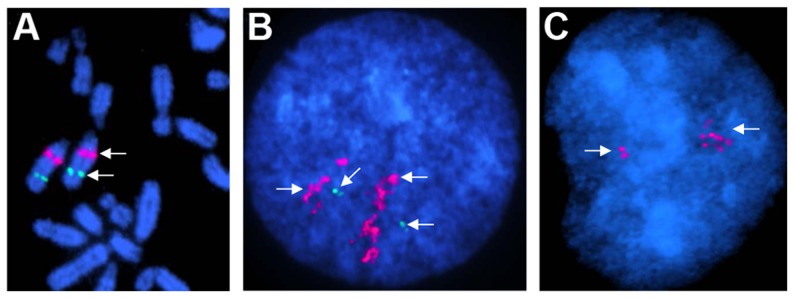
Chromosomal assignment and validation of a CNVR in chrUn (529–531 kb) by FISH.
A. Mapping the CNVR to chr19q12–q13 by FISH with BAC 132B13 (red); green - a control BAC with UMPS gene in chr19q21 [93]; B. The CNVR (red) in interphase chromosomes of a Percheron; green – a single-copy control probe; C. The CNVR (red) in interphase chromosomes of a Thoroughbred (Twilight). Note the difference in copy numbers between the Percheron and the Thoroughbred, as well as between homologous chromosomes.